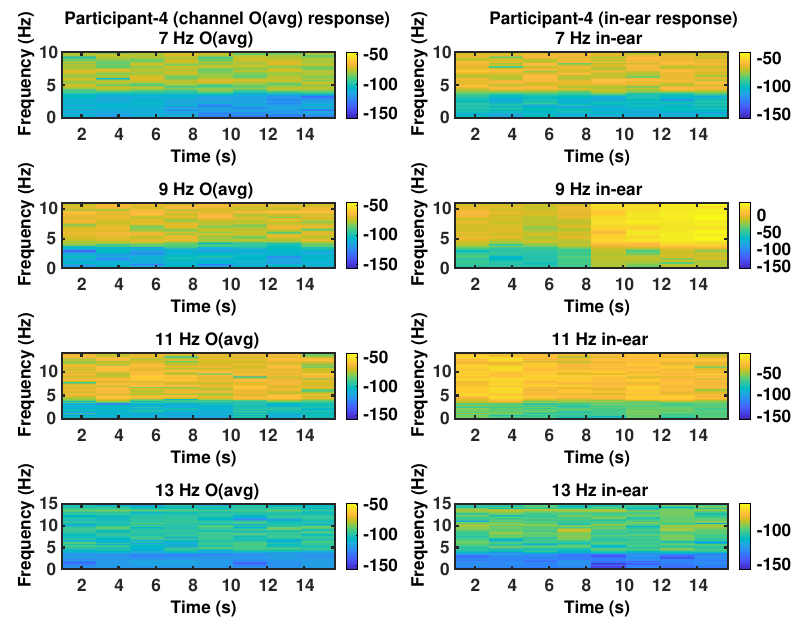
Figure 10. Spectrogram of participant 4 from occipital and in-ear electrode.